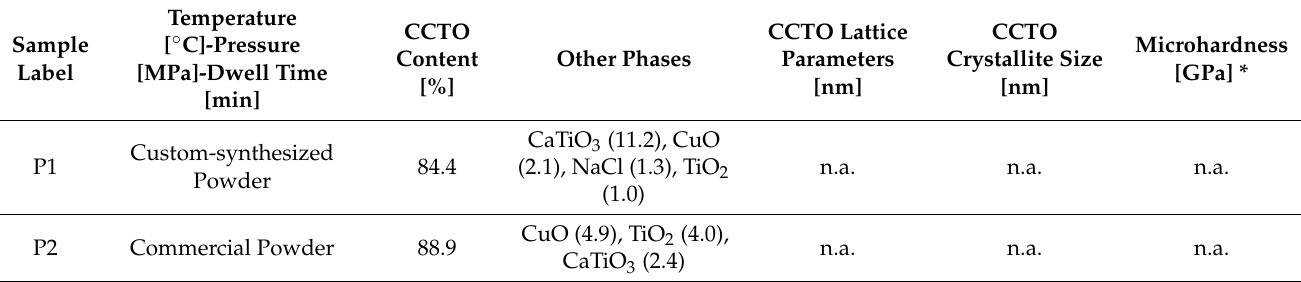
Figure 5. XRD analysis of sample F (see Table 1) fired at 1050 ◦ C for 2 h from the P2 powder. Grey color indicates the “difference between fit and model”. Table 2. Comparison of phase analysis, lattice parameters and microhardness of CCTO ceramics prepared by different